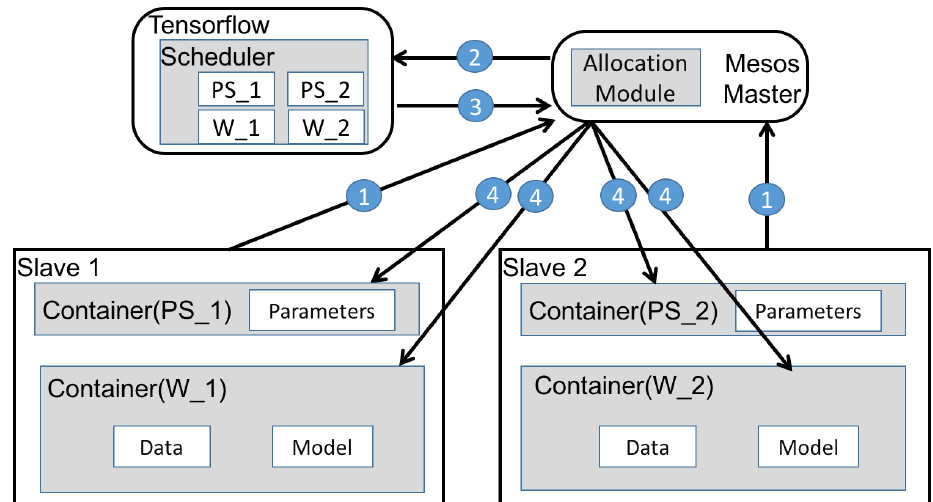
Figure 2. Procedures of resource management in Mesos for a Tensorflow